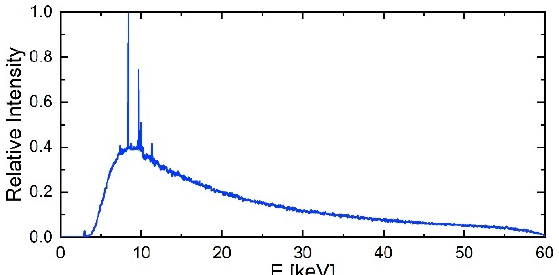
Figure 2. Monte Carlo simulated intensity spectrum of X-rays from the nano focus source used, considering the real geometry (exit window and air absorption for 280 mm detector distance). Sim- ulation performed in G4beamline 3.06 [35], based on GEANT4 [36].